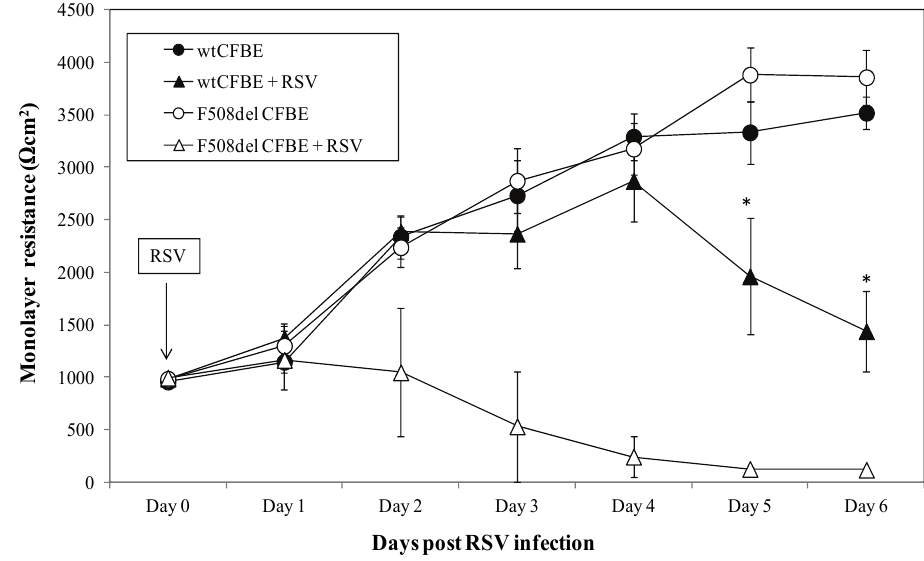
Figure 1. Resistance measurements across wt and F508del CFTR expressing CFBE41o- monolayers post RSV inoculation. Transepithelial resistance was measured daily (up to 6 days) in CFBE41o- cells transduced to overexpressed wild type (wt) CFTR or F508del CFTR. The white circles represent uninfected CFBE41o- cells expressing F508del CFTR while the black circles represent uninfected CFBE41o- cells expressing wt CFTR. The triangles represent CFBE41o- cells expressing wt CFTR (black) and F508del CFTR (white) infected with RSV A2 at a MOI of 0.1. Each time point represents the mean data obtained from 12 separate